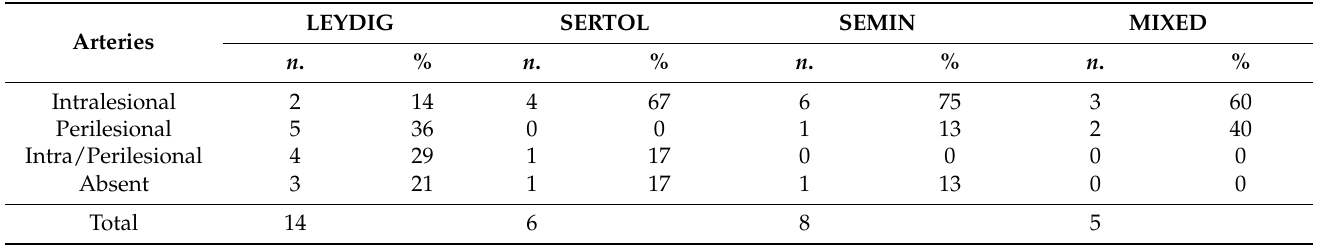
Table 2. Color Doppler characterization of arterial distribution in different tumor lesions ( n = 33) included in the comparative analysis. The arteries (number and relative frequencies) were categorized as intralesional, perilesional, intra/perilesional, or absent.